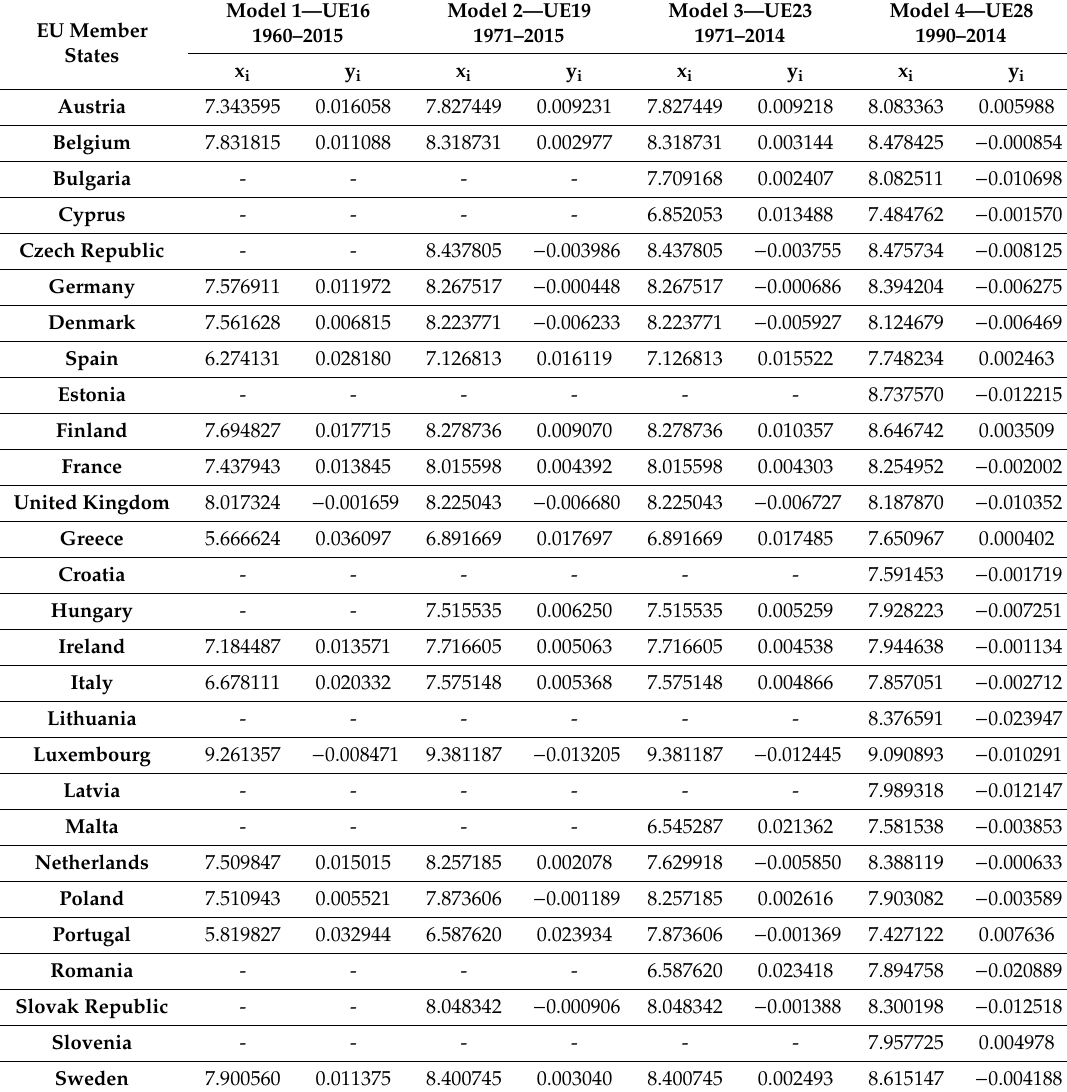
Table 1. β -convergence of energy consumption for the 4 models of